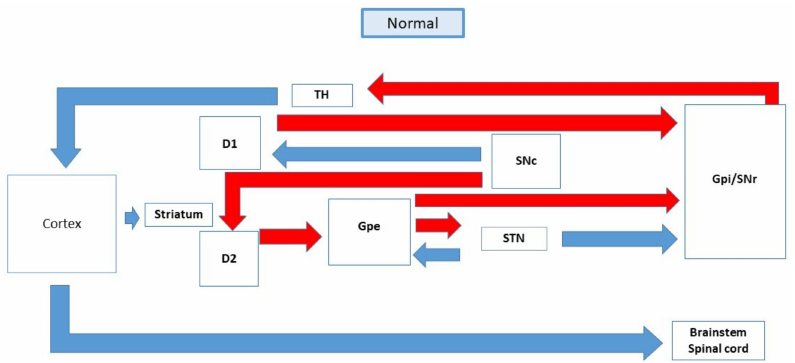
Figure 1. The schematic diagram of the basal ganglia and their connections in normal patient.